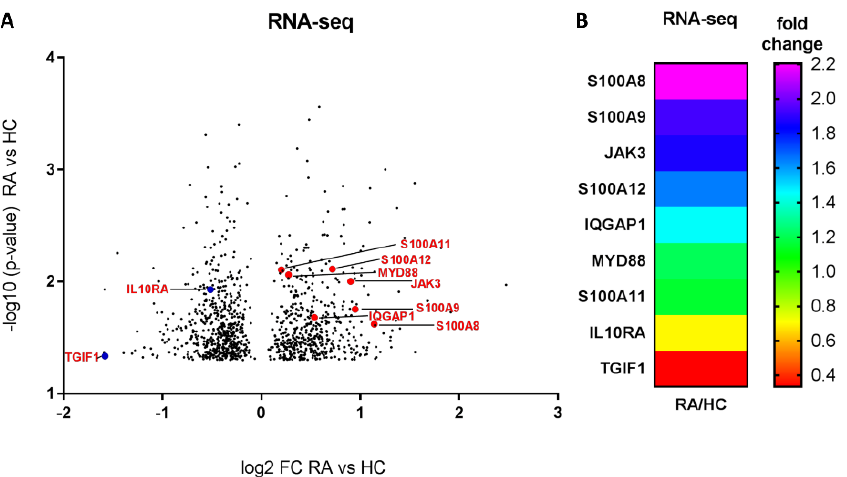
Figure 1. Global analysis of transcriptomic expression profiles between healthy control (HC) and rheumatoid arthritis (RA) monocytes. The volcano plot shows upregulated (red dots) and down- regulated (blue dots) transcripts in RA ( n = 4) compared with HC ( n = 4) monocytes ( A ). Heatmap of S100A8, S100A9, JAK3, S100A12, IQGAP1, MYD88, S100A11, IL10RA, and TGIF1 transcripts in RA compared with HC monocytes. The colors in the heatmap represent the expression intensity of the transcripts ( B ). Table 1. Clinical and laboratory data of RA patients.